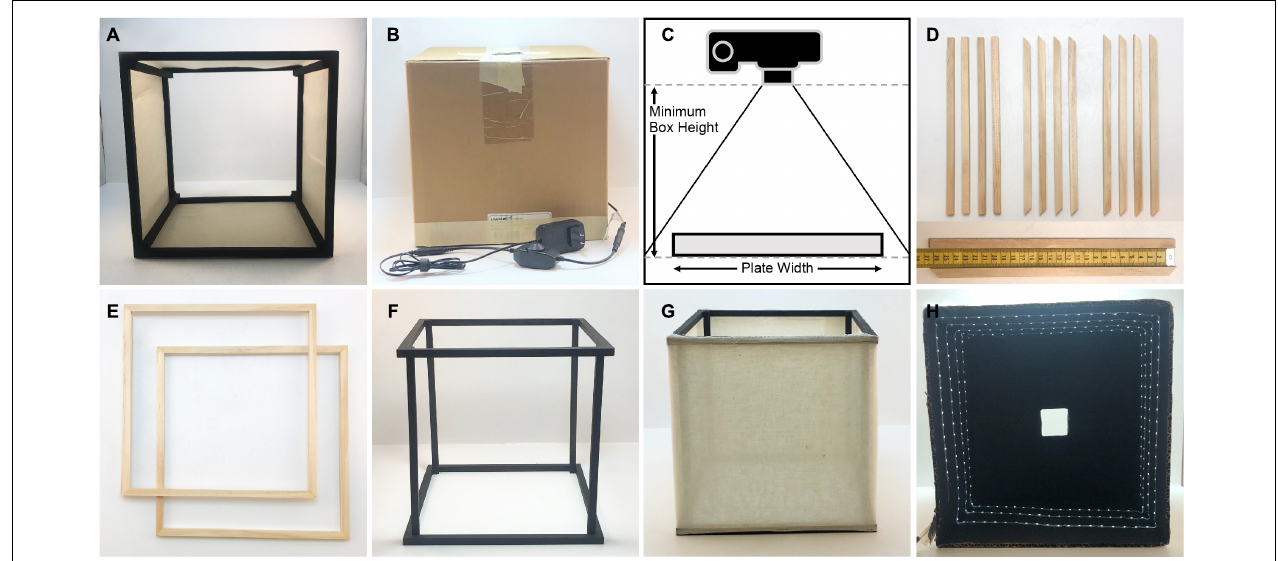
FIGURE 1 | Components and construction of the imaging box. (A) Light diffusing component of the imaging box that is open on the top and the bottom (side view). (B) Light box component of the imaging box that eliminates unwanted light and glare while providing lighting for imaging. (C) Determining the necessary height for the imaging box. (D) Twelve square wooden dowels cut for the construction of the light diffuser, eight cut with 45 ◦ angles and four cut with 90 ◦ angles. The measuring tape on the bottom indicates dowel length in centimeters. (E) The top and bottom frames of the light diffuser constructed using the eight wooden dowels cut with 45 ◦ angles. (F) The assembled diffuser frame painted matte black. (G) The completely assembled diffuser. (H) The inside of the light box showing the LED light strip on the sides of the box, the matte black interior, and the square hole in the top of the box.